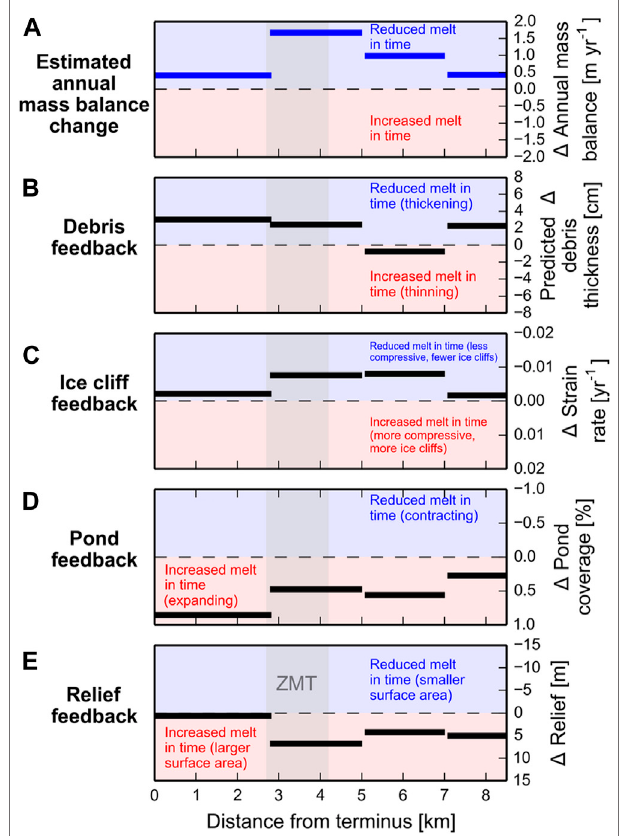
FIGURE 9 | Spatial distributions of terms indicating the sign of feedbacks.Thetitleofeachpanelisontheleftside.Ineachpanelblueshading indicates the area where melt will be reduced in time. Red shading indicates the portion of each panel in which melt will be increased in time. Grey shading indicates the extent of the zone of maximum thinning (ZMT). For (B – D) iftheblackbarsareintheblueareathefeedbackisnegative.Iftheblack bars are in the red area the feedback is positive. (A) Observed change in annualmassbalanceshowingareductionofmeltintimeacrossthestudyarea (see Figures 3B,E ). (B) Representation ofthe negativedebris feedback using predictedchangeindebristhicknessintimeasaproxy.Debristhickensdueto changesinsurfacevelocities,strainrate,andmeltoutleadingtoareductionof meltintime. (C) Representationofthenegativeiceclifffeedbackusingchange in surface compression (strain rate) as a proxy. Ice cliffs are positively correlated with strain rate, meaning areas with decreased compression tend to have fewer ice cliffs. Positive values indicate increased compression and negative values decreased compression in time. (D) Representation of the positivepondfeedbackusingthechangeinpondcoverage intimeasaproxy. (E) Representationoftherelieffeedback.Thesteepeningoflocalslopesonthe glacier increases the total area of ice subject to surface melt within and above the ZMT.